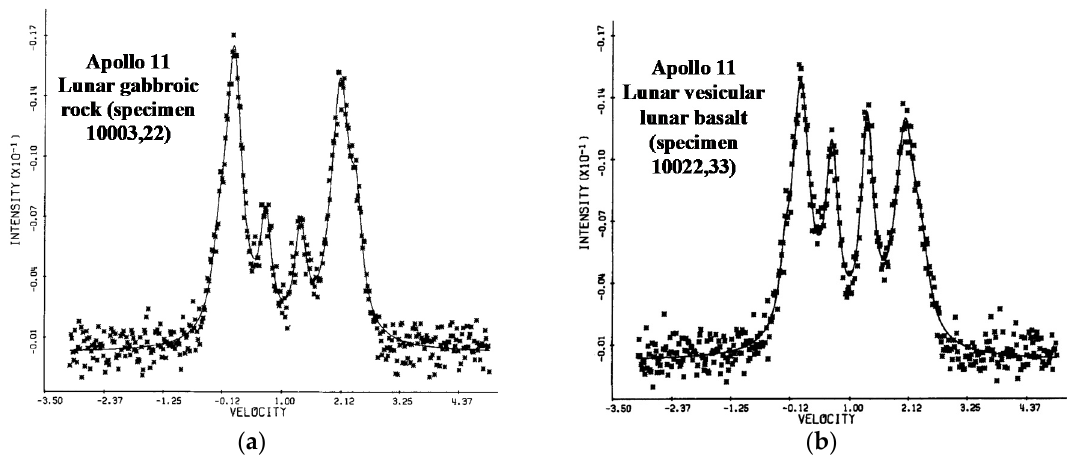
Figure 41. Mössbauer spectra of Lunar samples (Apollo 11) measured at room temperature in the small velocity range and backscattering geometry: gabbroic rock, specimen 10003,22 ( a ) and vesicular basalt, specimen 10022,33 ( b ). Adapted from [102].